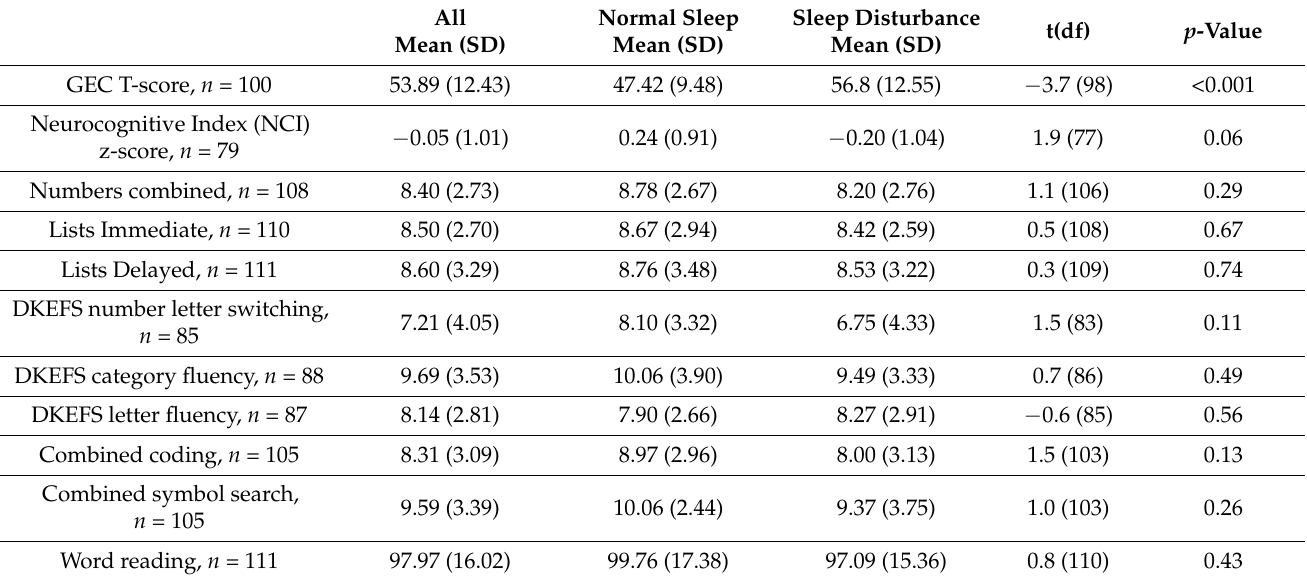
Table 2. Average scores on cognitive outcomes by sleep disturbance group.